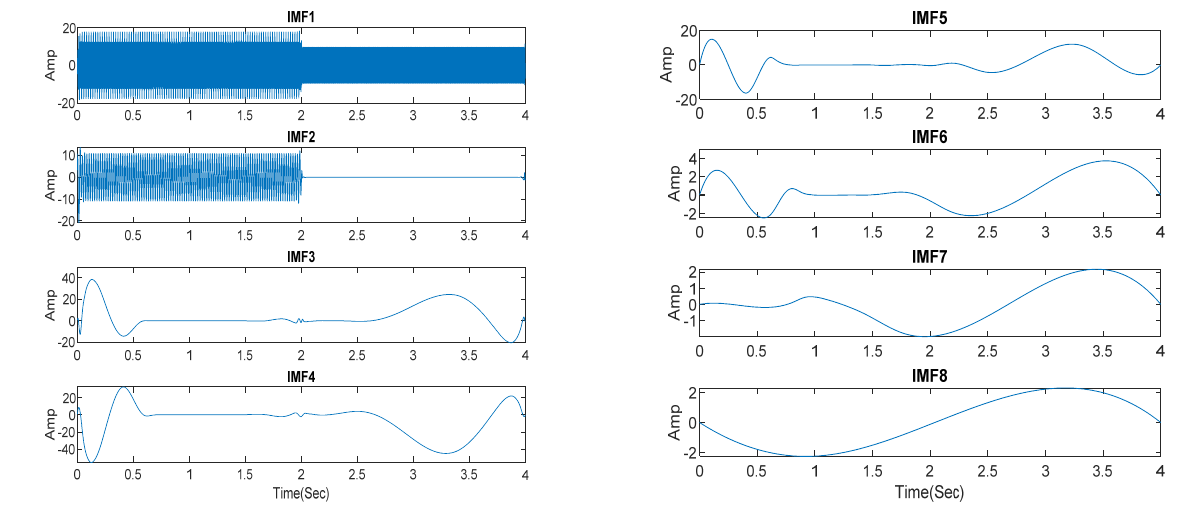
Figure 2. Intrinsic Mode Functions (IMFs) of the multicomponent nonstationary signal.